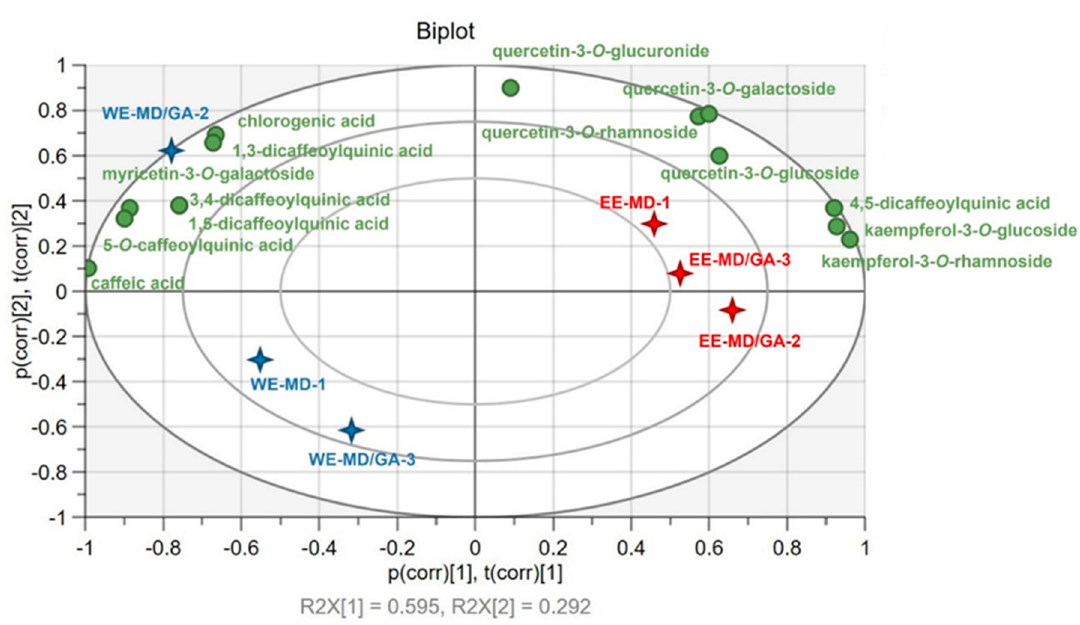
Figure 3. PCA biplot showing the distribution of phenolic compounds in different spray-dried C. paliurus powders; WE, aqueous extract; EE, ethanol extract; MD, maltodextrin (10–13 DE); GA, gum acacia. The numbers indicate the wall materials ratio; 1 = only MD, 2 = MD:GA of 1:1 ratio, 3 = MD:GA of 1:3 ratio.